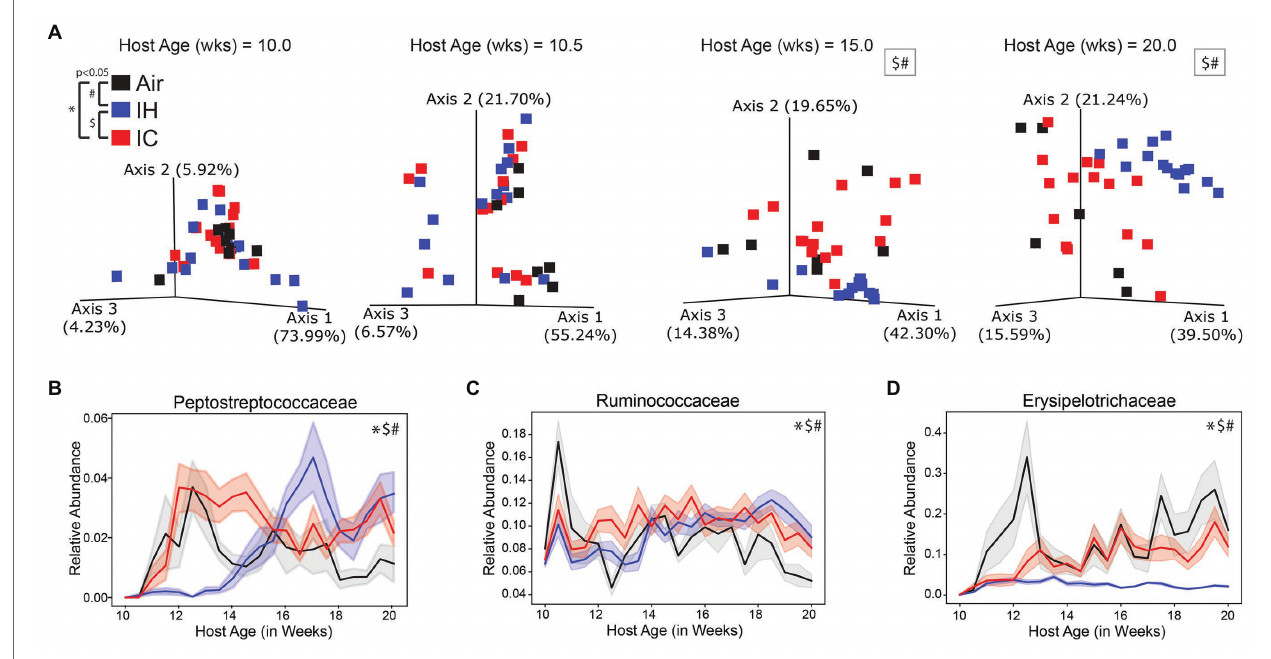
FIGURE 2 | 16S microbiome of ApoE −/− mice on HFD during chronic 10-week treatment. (A) Weighted UniFrac PCoA of the microbiome during four key time points, each time point calculated in isolation. Longitudinal relative abundance values for (B) family Peptostreptococcaceae; (C) family Ruminococcaceae; and (D) family Erysipelotrichaceae. PERMANOVA used for statistical comparisons at the population level. Linear mixed effect (LME) modeling used for statistical comparisons of individual families over time. The shaded areas in parts (B–D) represent standard error of the mean. Air/controls are black ( n = 6), IH is blue ( n = 12), and IC is red ( n = 12). Statistical significance p < 0.05, *IC vs. Air, # IH vs. Air, and $ IH vs.